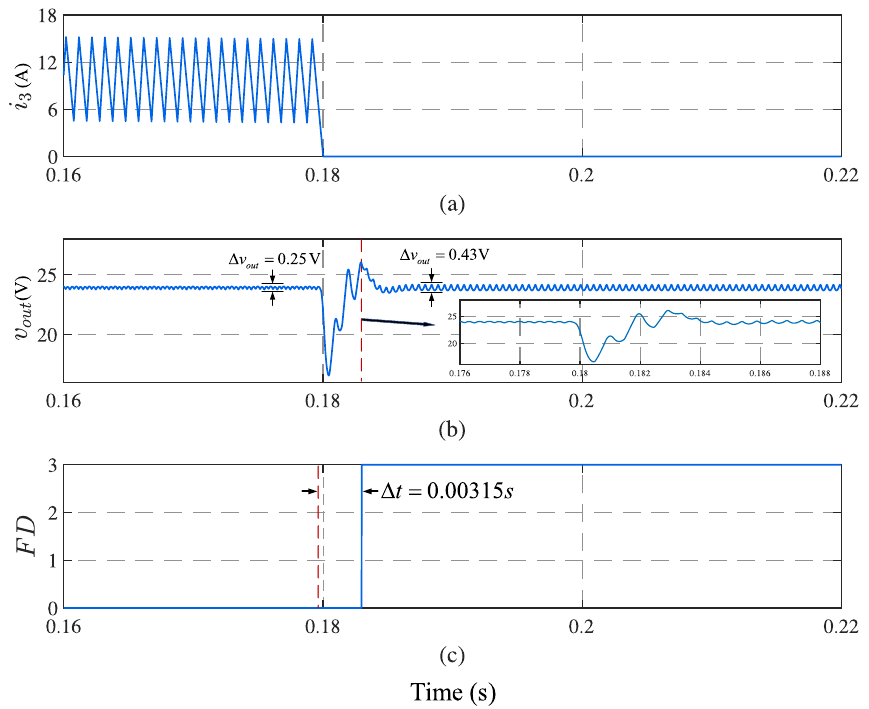
Figure 11. Waveforms after an OCF in branch 3 with the proposed method: ( a ) branch 3 current, ( b ) the output voltage at load side, and ( c ) the instantaneous state FD corresponding to an